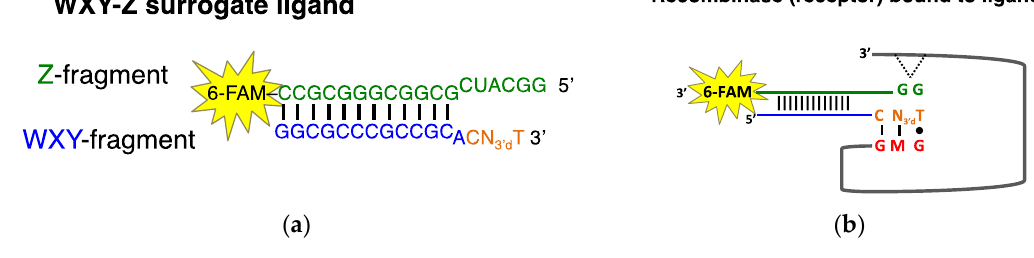
Figure 2. Fluorescence anisotropy ligand and receptor design. ( a ) Design of the surrogate WXY - Z ligand. The “ WXY fragment ” (blue) contains the tag (orange) and a 3 (cid:48) deoxythymidine on the 3 (cid:48) end prevents catalytic reaction. The “N” nucleotide represents an A, C, G, or C nucleotide. The Z fragment (green) contains the 3 (cid:48) fluorescent label 6-FAM (6-carboxyfluorescein). The ligand molecular weight is approximately 11 kDa with a T m = 90 ◦ C; ( b ) Schematic of the surrogate WXY - Z ligand binding to the WXYZ recombinase ribozyme (receptor) at the IGS (red) and tag (orange) interface. A binding interaction also occurs between the G on the 5 (cid:48) side of the “ Z fragment ” and the G-binding site on the ribozyme (indicated by dotted lines). The IGS “M” can represent any of the four nucleotides. The molecular mass of the Azoarcus recombinase ribozyme is approximately 64 kDa; see ref. [21] for complete